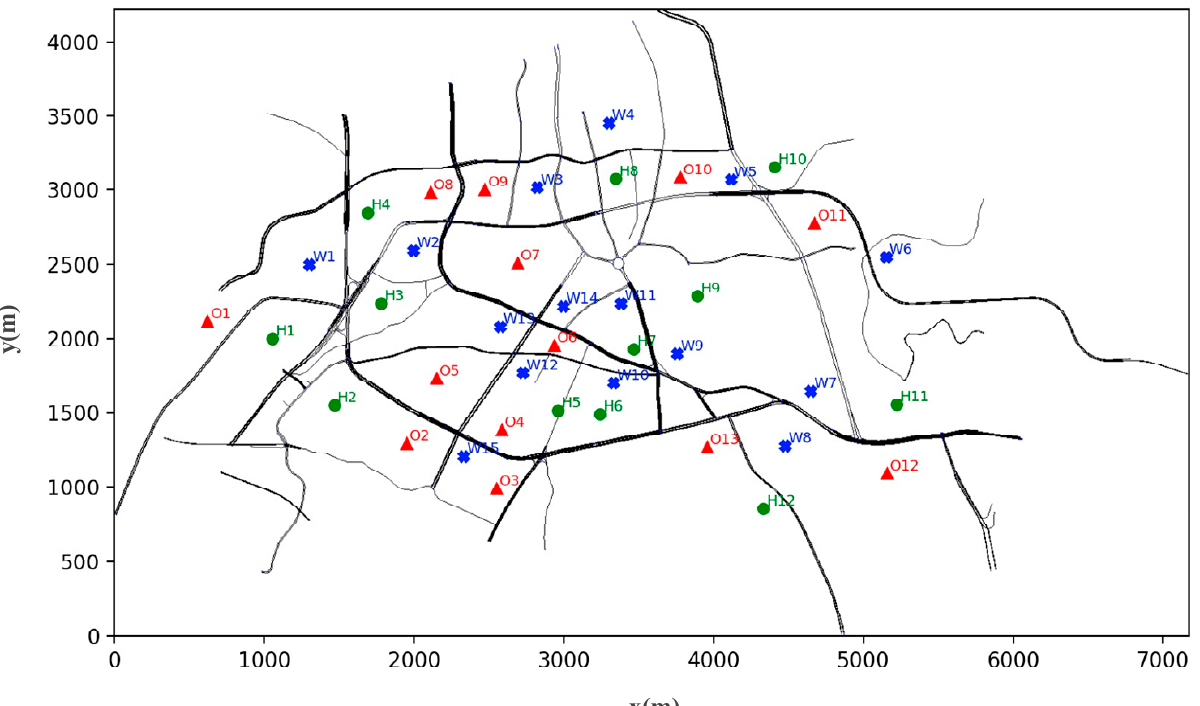
Figure 3. Actual fast charging station planning area.